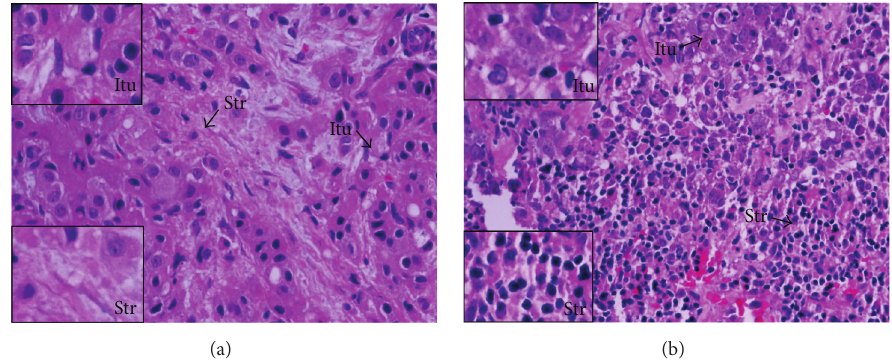
Figure 1: TILs in the sections of LLABCs, using H&E staining, at 400x magnification; (a) low level of lymphocytic infiltration; (b) high level of lymphocytic infiltration. Low level of TILs defined as ≤ 60% of tumour nests (Itu: intratumoural) and stromal areas (Str: stromal) infiltrated by lymphocytes. High level of TILs defined as > 60% of tumour nests and/or stromal areas infiltrated by